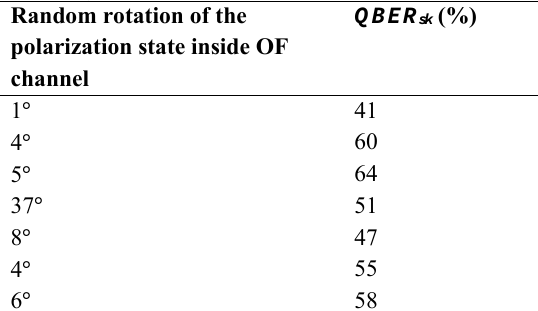
The effect of the optical pulses polarization rotation on the system QBER sk Random rotation of the polarization state inside OF